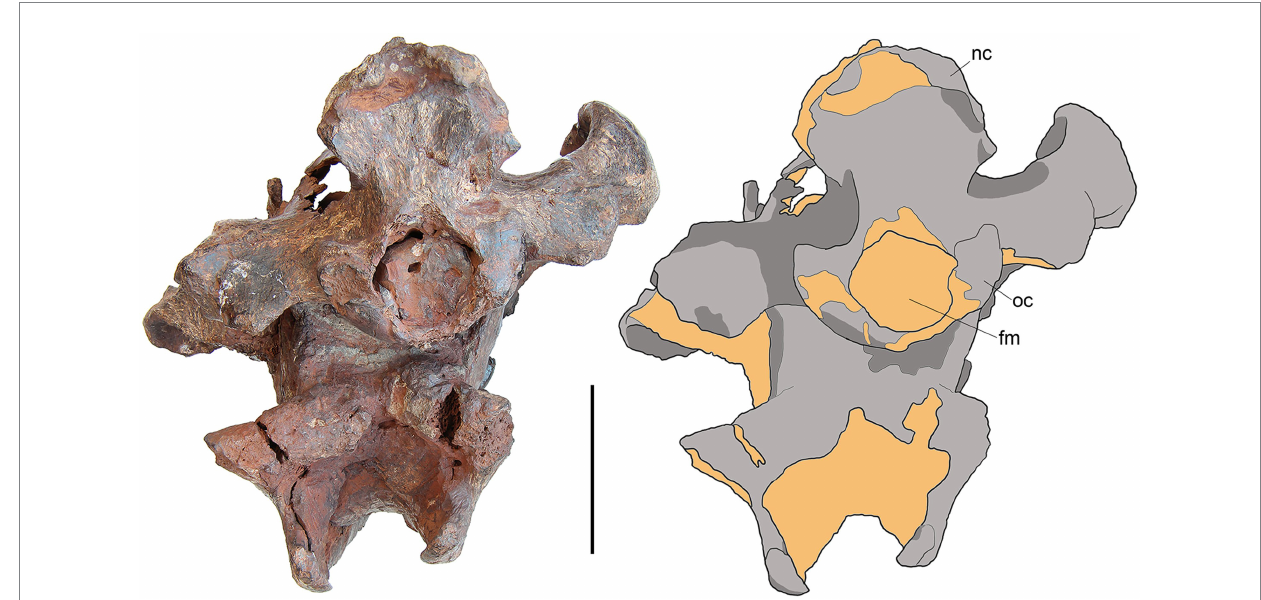
FIGURE 6 M. peregrinus , gen. et sp. nov., SYSU-M-5, holotype, a partial skull with associated mandibles in posterior view (photograph and explanatory drawing). Youganwo Formation, upper Eocene, Maoming locality, Guangdong Province, China. fm, foramen magnum; oc, occipital condyle; nc, nuchal crest. Scale bar equals 5 cm.